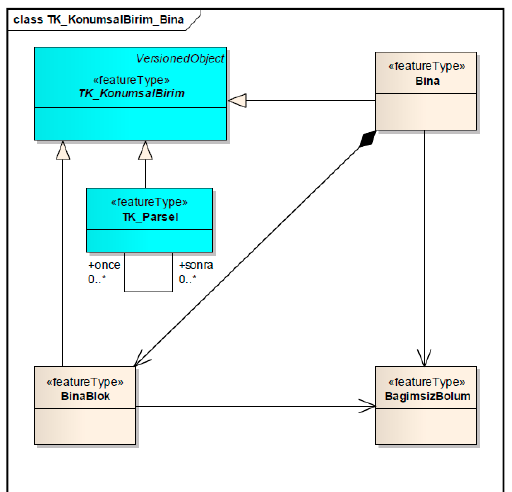
Figure 6. Individual unit class in relation with building and building block classes. Translation of some of the expressions: ‘Bina’ = ‘Building’, ‘BinaBlok’ = ‘BuildingBlock’, ‘BagimsizBolum’ =